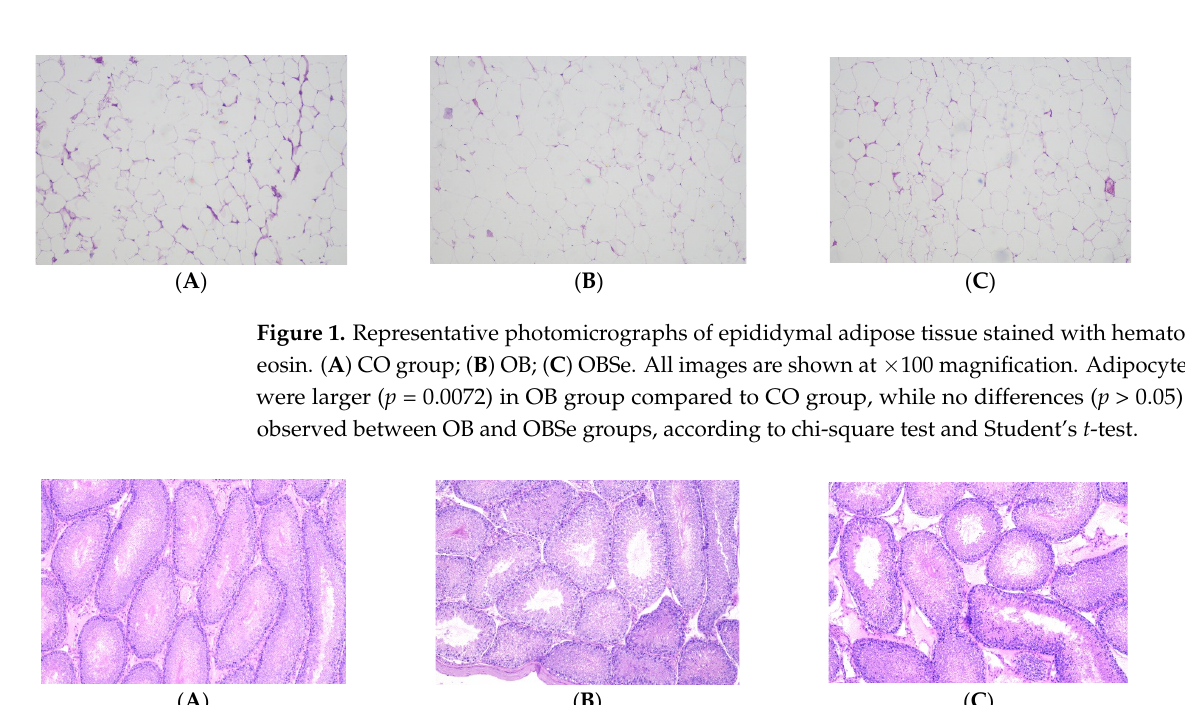
Figure 2. Testicular architecture. Representative photomicrograph of testicular tubules stained with hematoxylin-eosin. ( A ) CO group; ( B ) OB; ( C ) OBSe. All images are shown at ×10 magnification. No statistically significant difference ( p > 0.05) among groups according to chi-square test and Student’s t -test.